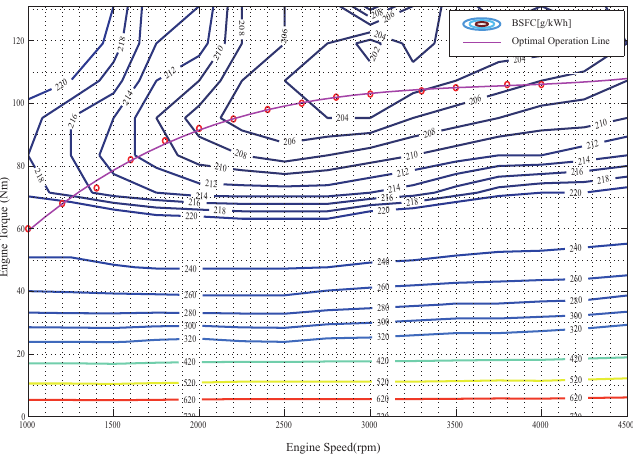
Figure 2. Break-specific fuel consumption (BSFC) map and optimal operation line of the